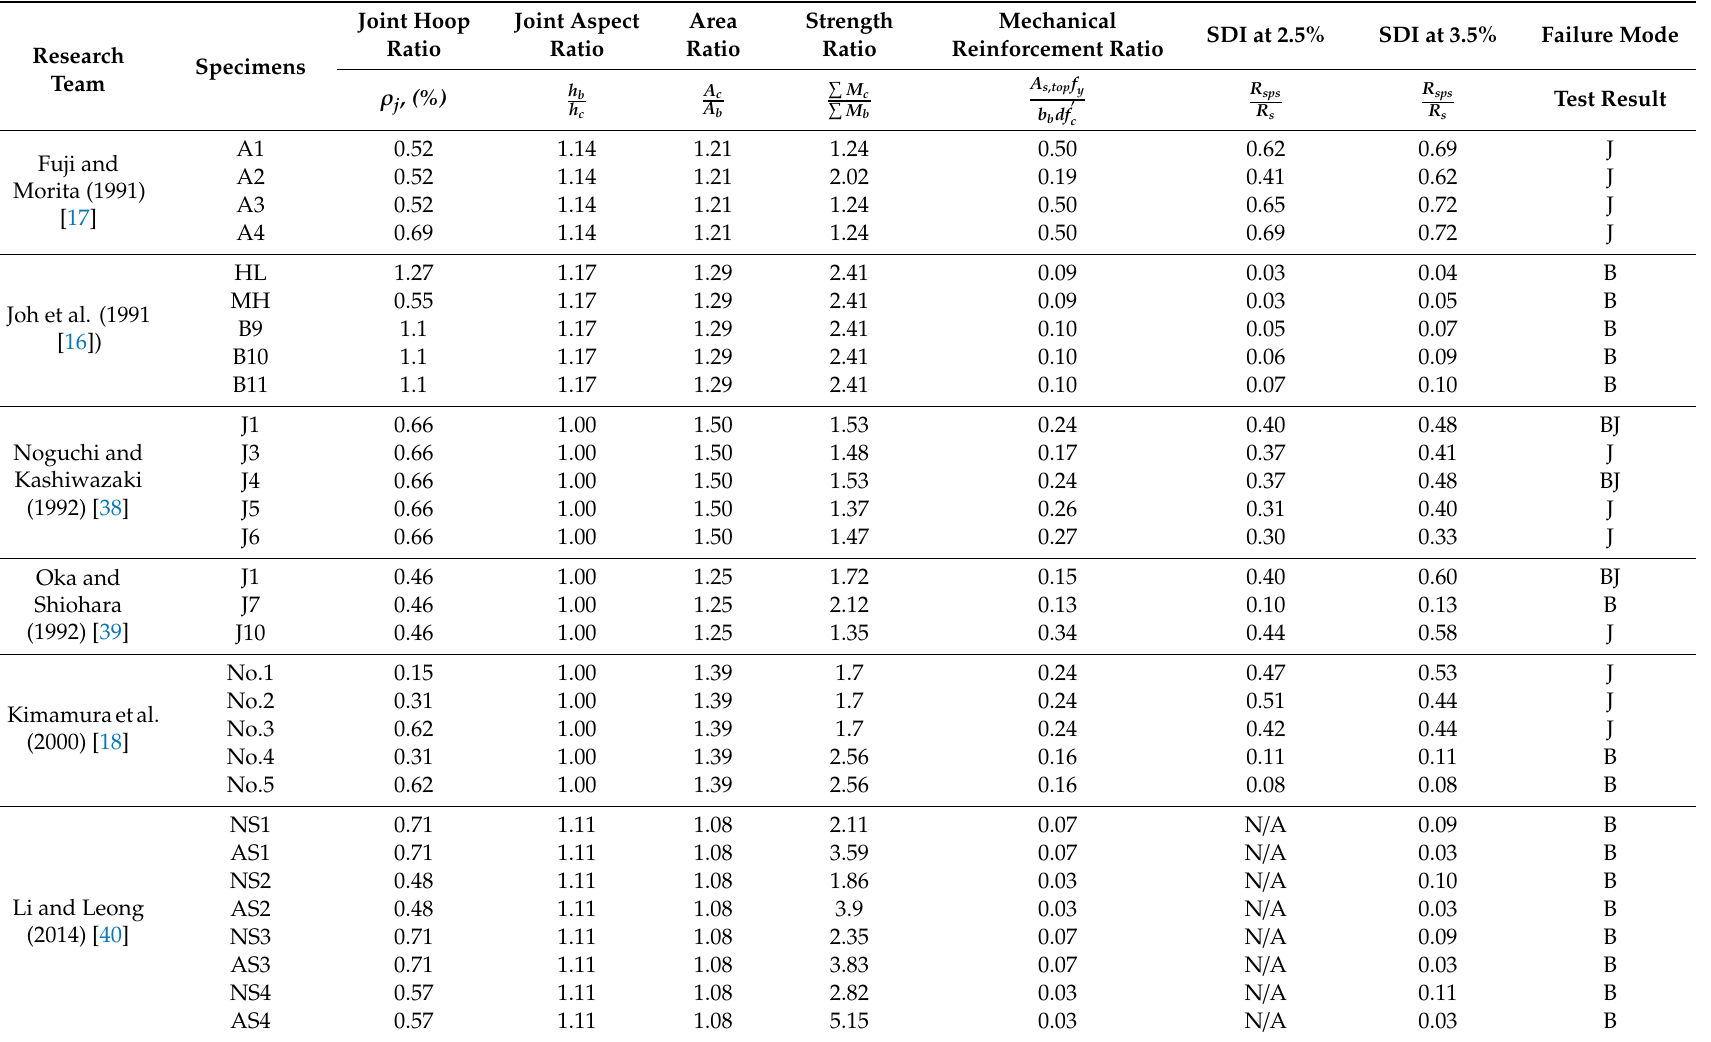
Table A3. Analysis Parameters of Existing Test